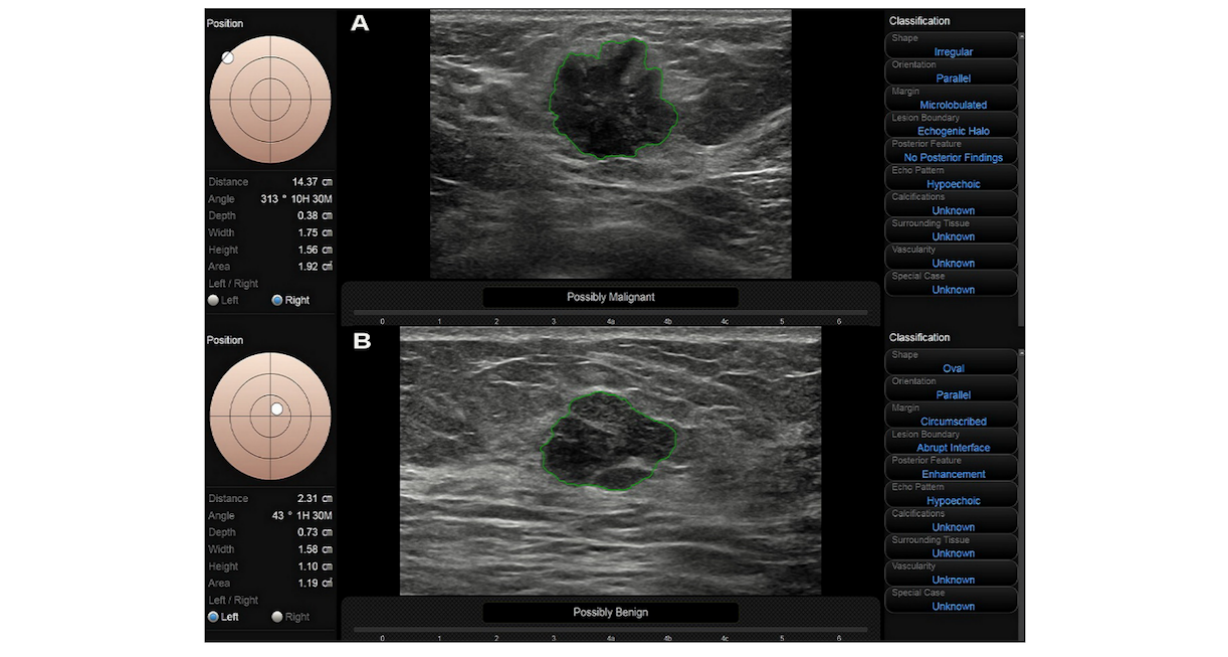
Figure 3. A malignant and benign lesion < 2 cm diagnosed correctly by